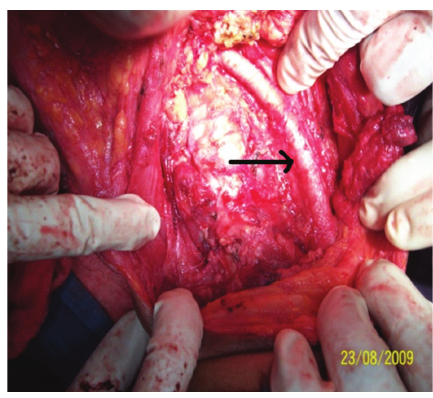
Figure 6: Picture showing right carotid artery (arrow) and trachea on removal of cysts and total thyroidectomy.